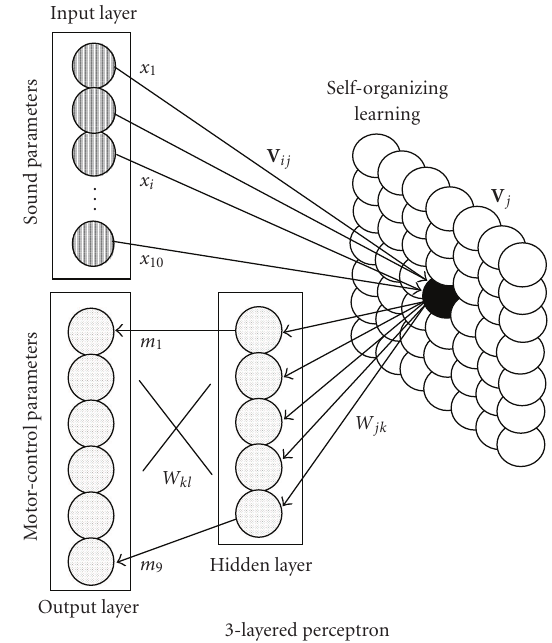
Figure 2: Structure of self-organizing neural network.